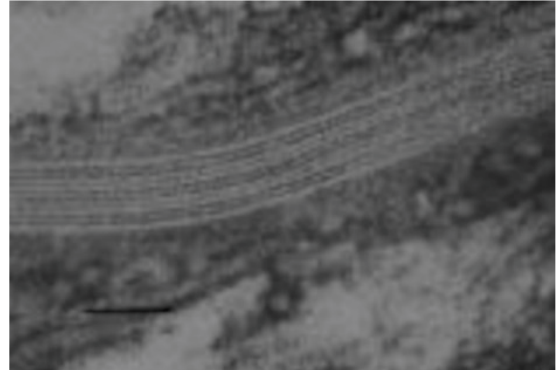
Figure 1. Transmission electron micrograph of an intercellular space in the stratum corneum [5]. The human skin specimen was fixed with ruthenium tetroxide. Bar = 50 nm.